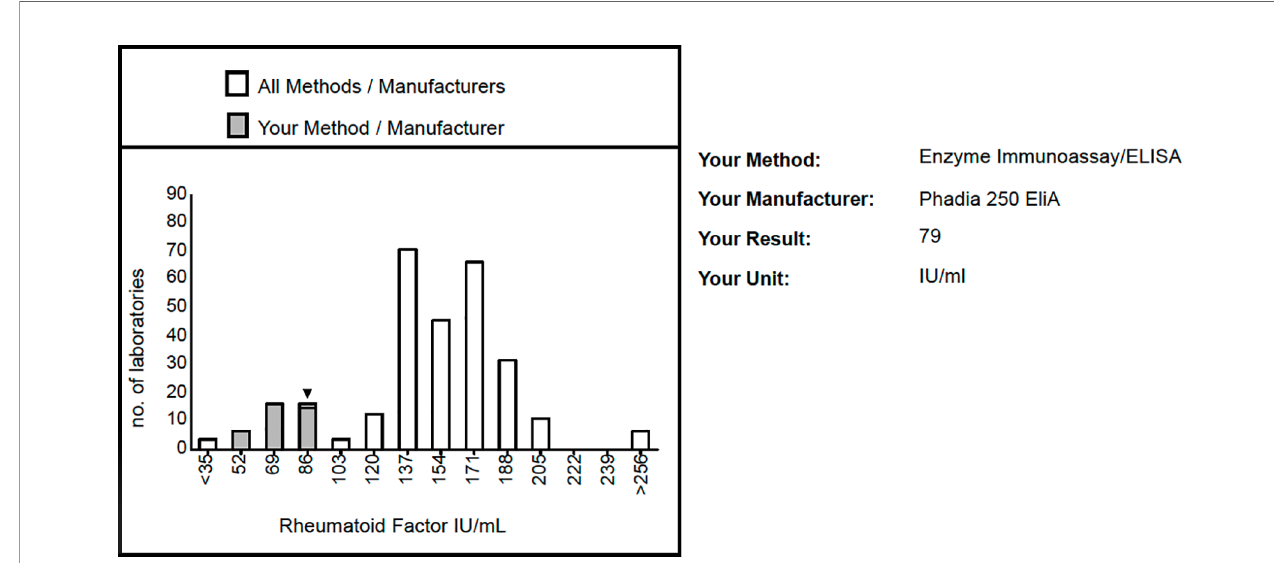
FIGURE 1 | Excerpt from the response from the British External Quality Assessment provider UK NEQAS to one individual laboratory on the October 2020 distribution of rheumatoid factor. Responses had been submitted from 312 laboratories, out of which 308 were correctly positive and four incorrectly reported as negative. The histogram bars show the quantitative distribution for all participating labs, with the distribution of labs using the same commercial assay as this individual laboratory in grey. The fi gure is published with the permission of Dina Patel, UK